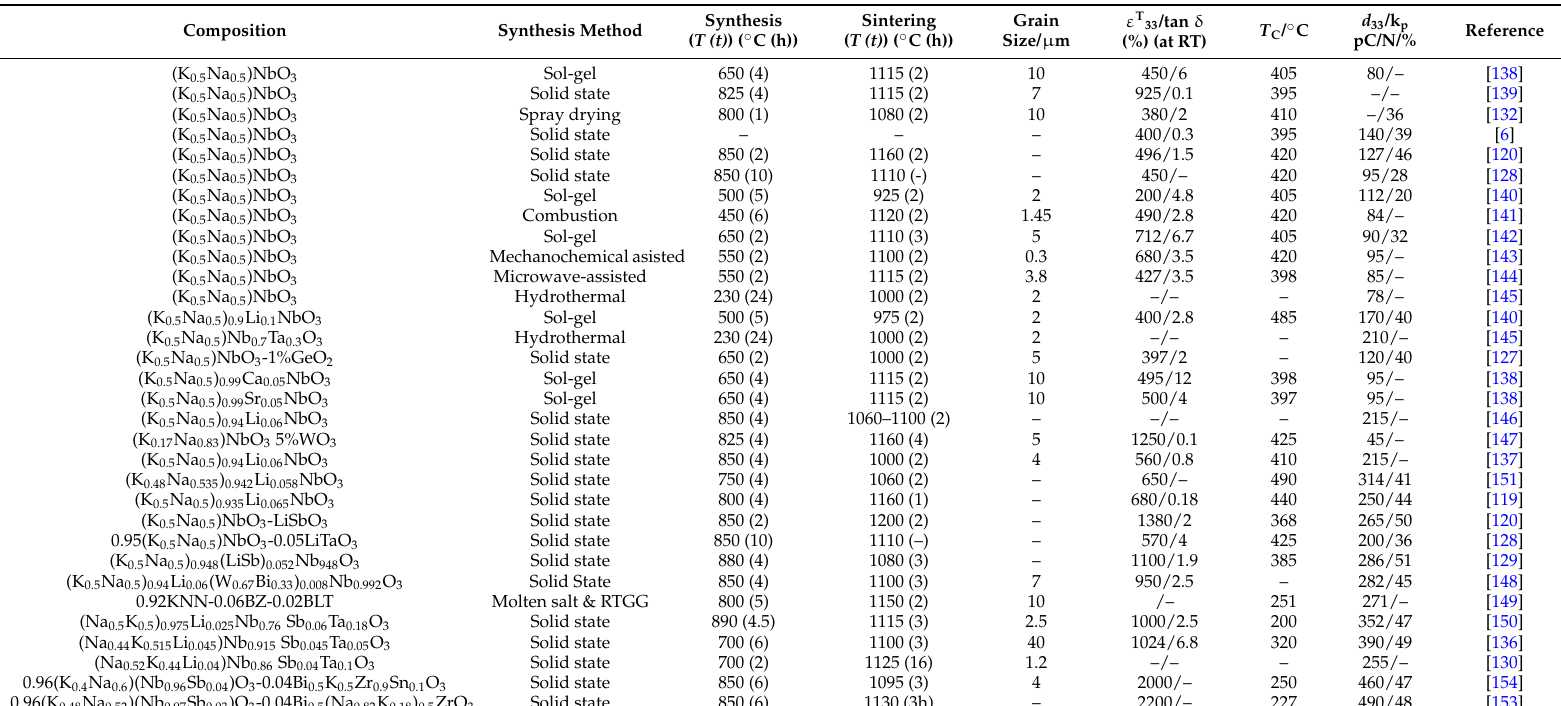
Table 3. Some results of the publications on compositions based on (K 0.5 Na 0.5 )NbO 3